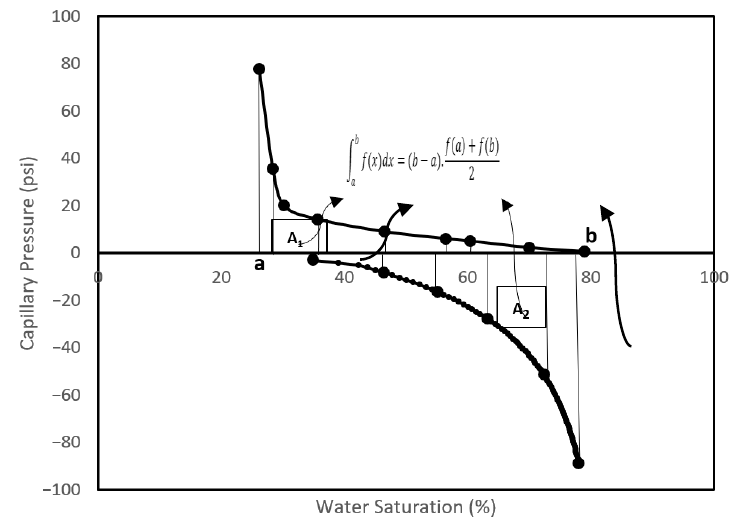
Figure A1. USBM wettability index from capillary pressure curves of dolomite 2.